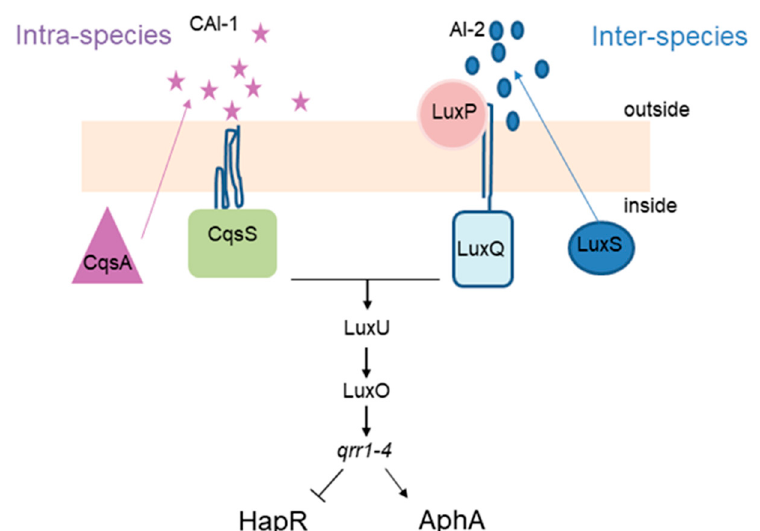
Figure 1. Simplified QS network of V. cholerae . Intra- and Inter-species autoinducers activate a phosphorylation cascade through LuxU and LuxO, leading to the expression of Qrr1–4 sRNAs which in turn promote expression of the AphA while inhibiting expression of HapR.